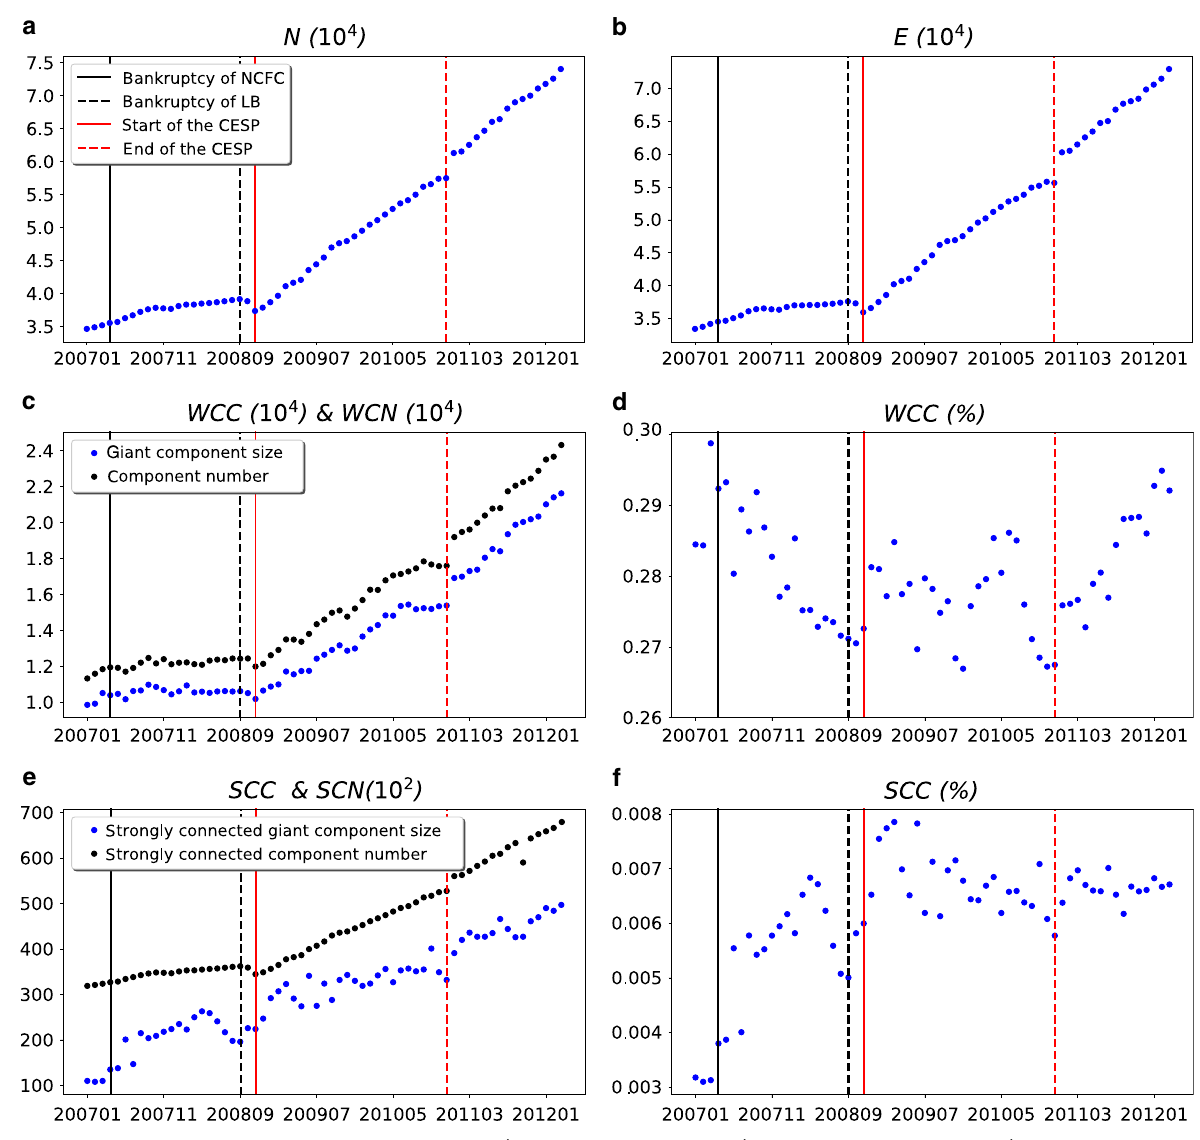
Fig. 1 Evolution of the scale of the guarantee network. a N (10 4 ): number of nodes. b E (10 4 ): number of edges. c WCC (10 4 ): size of the largest weakly connected component (giant component); WCN (10 4 ): weakly connected component number. d WCC (%): ratio of weakly connected giant component. e SCC : the size of the largest strongly connected component (giant component); SCN (10 2 ): count of strongly connected component. f SCC (%): ratio of strongly connected giant component. Source data are provided as a Source Data fi